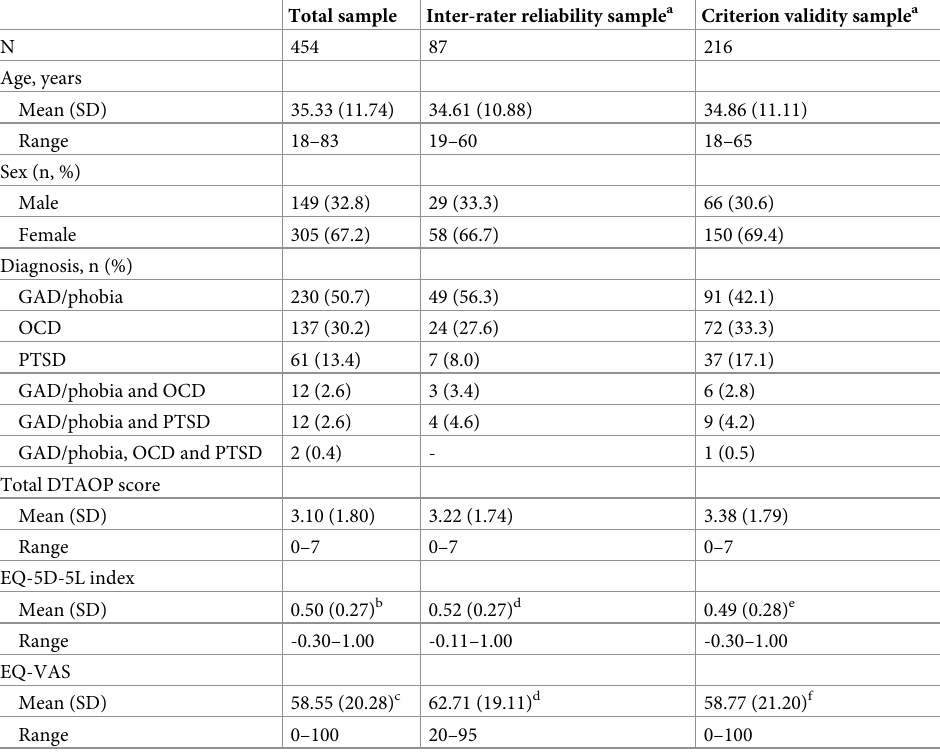
Table 2. Characteristics of the study sample.